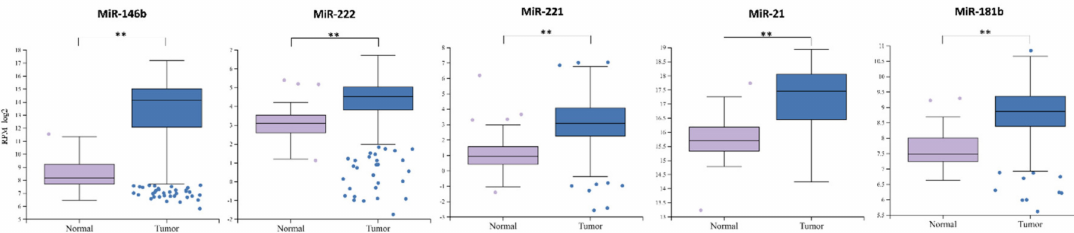
Figure 1. The comparison of miRNA expression between normal and cancerous tissue groups. The box squares represent the data within 25 and 75 percentiles, the line in the middle shows the median, the outliers are shown as dots. ** p < 0.0001. A total of 565 cases analyzed (normal n = 59, tumor n = 506).